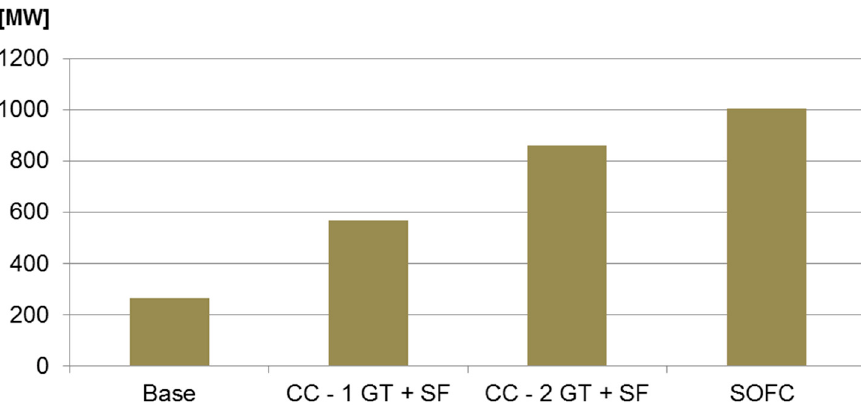
Figure 5. Comparison performance of the repowering plants in terms of power. SF = supplementary firing, CC = repowered combined cycles, GT = gas turbine, SOFC = solid oxide fuel